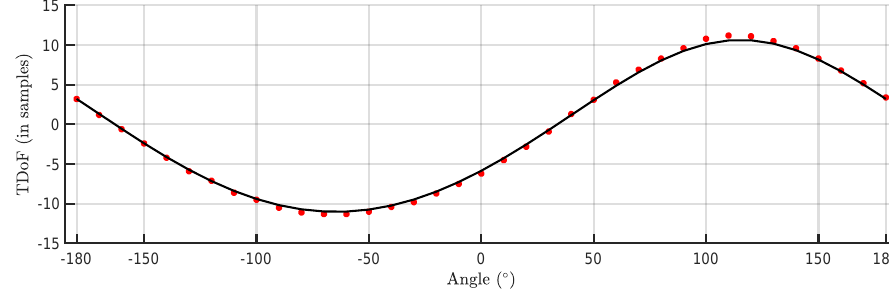
Figure 5. Median of all TDOA versus rotation